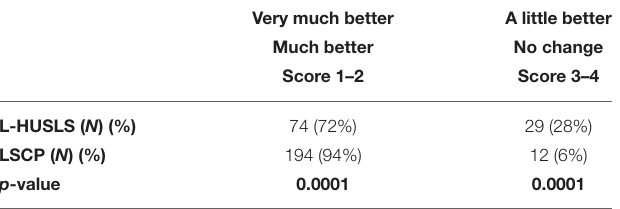
TABLE 3 | Patient global Impression of Improvement